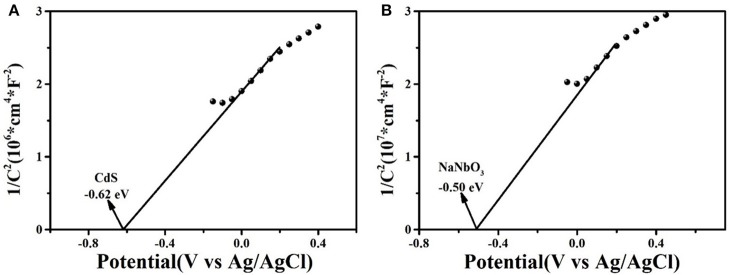
M–S plots of (A) CdS and (B) NaNbO3.